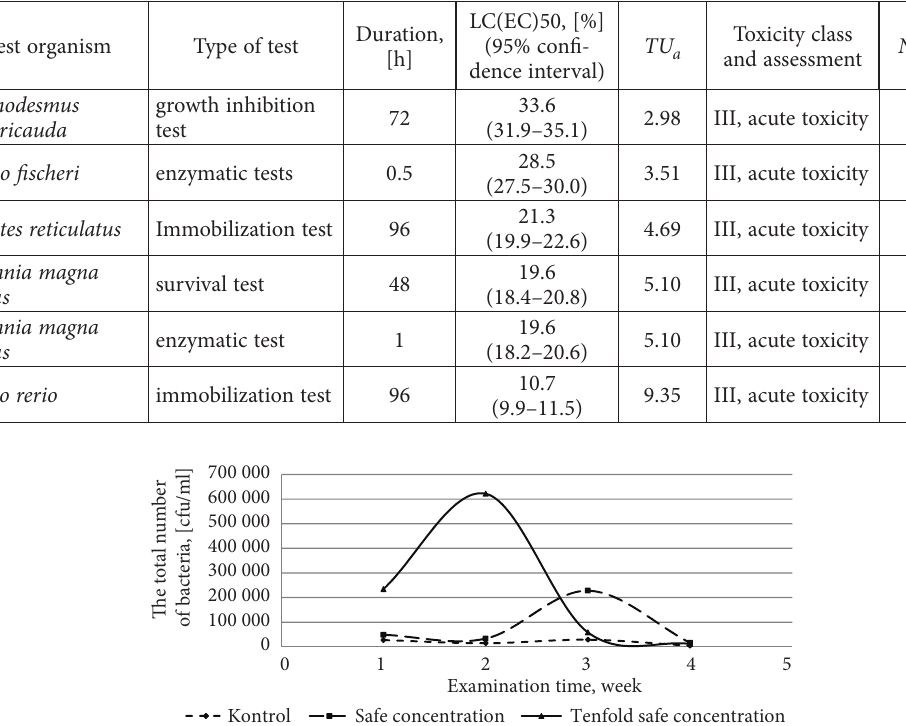
Figure 1. Dynamics of changes in the total number of bacteria in microcosm study